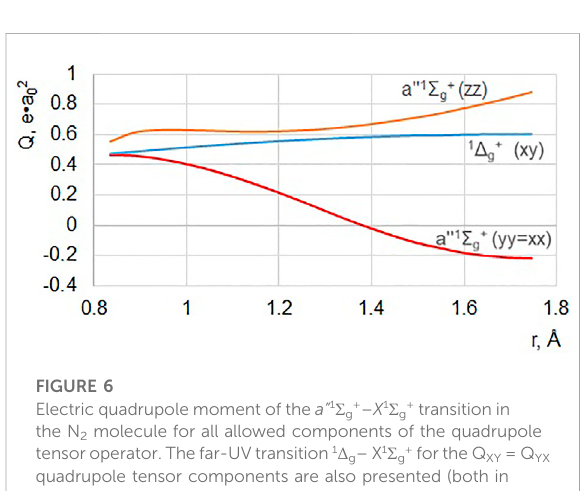
FIGURE 6 Electric quadrupole moment of the a ” 1 Σ g + – X 1 Σ g + transition in the N 2 molecule for all allowed components of the quadrupole tensoroperator.Thefar-UVtransition 1 Δ g – X 1 Σ g + fortheQ XY =Q YX quadrupole tensor components are also presented (both in a.